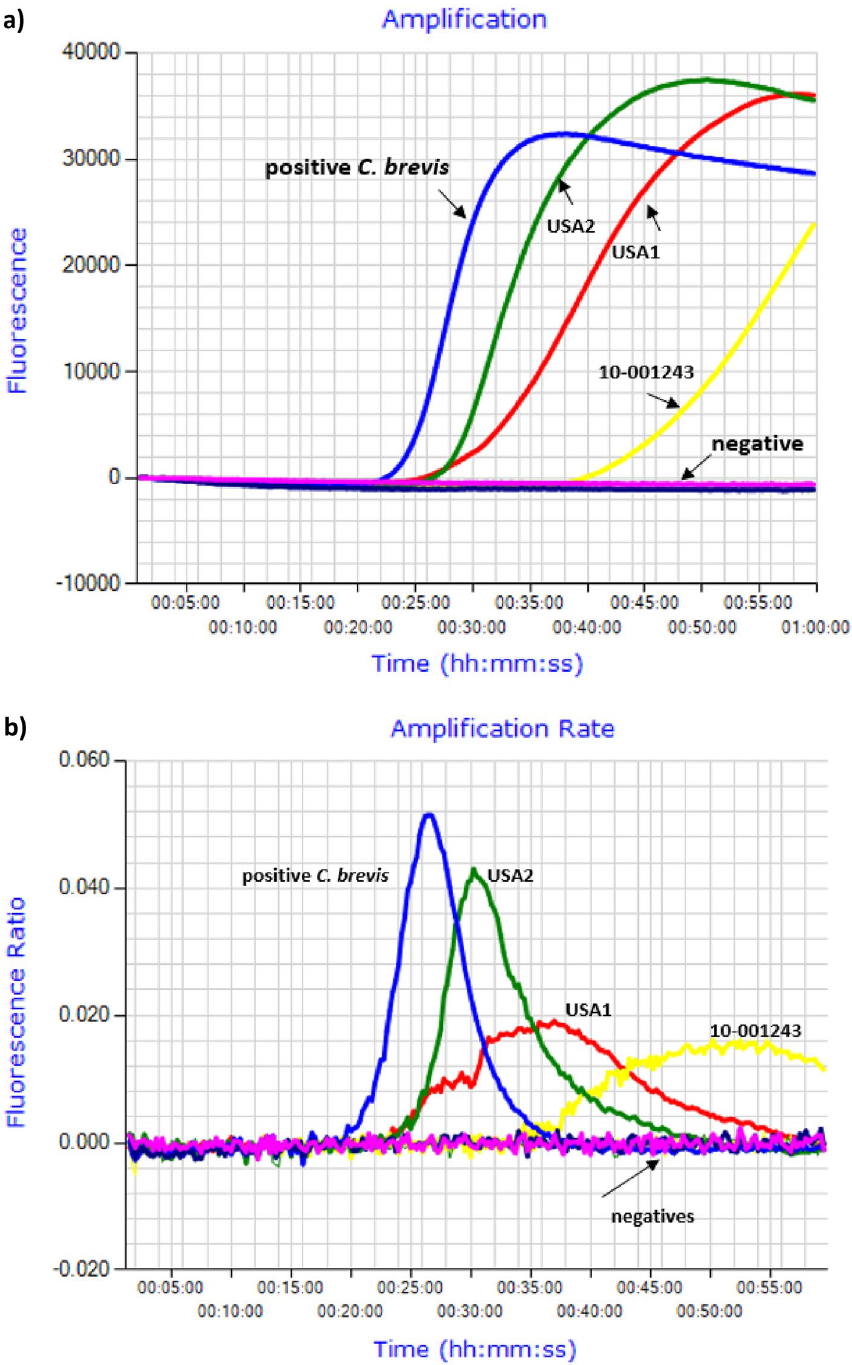
Figure 4. LAMP assay performed on DNA extracts from pellets samples of C. brevis , C. domesticus , C. dudleyi, and I. minor . ( a ) Amplification profile with positive samples amplifying from ≤ 30 min ; positive = positive C. brevis control; negative = negative samples including negative control showing flat line. ( b ) Amplification rate of LAMP amplicons with anneal derivative 80.5–80.6